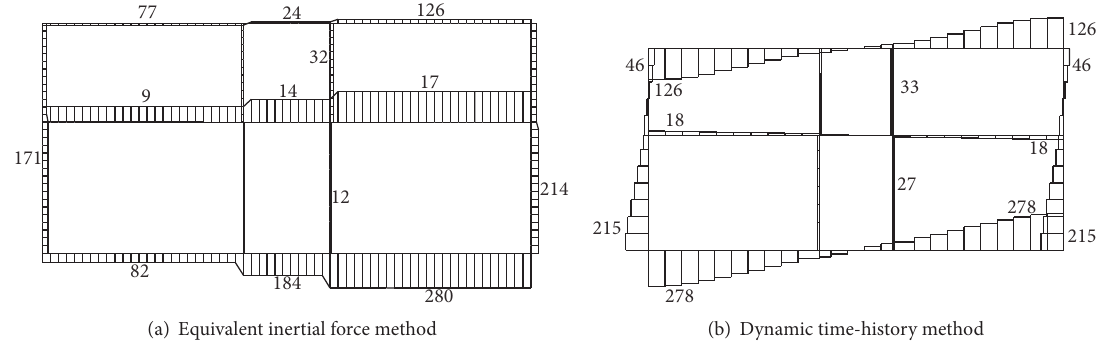
Figure 10: The axial force diagram of the maximum dynamic internal force of two layers and three crosses station structure